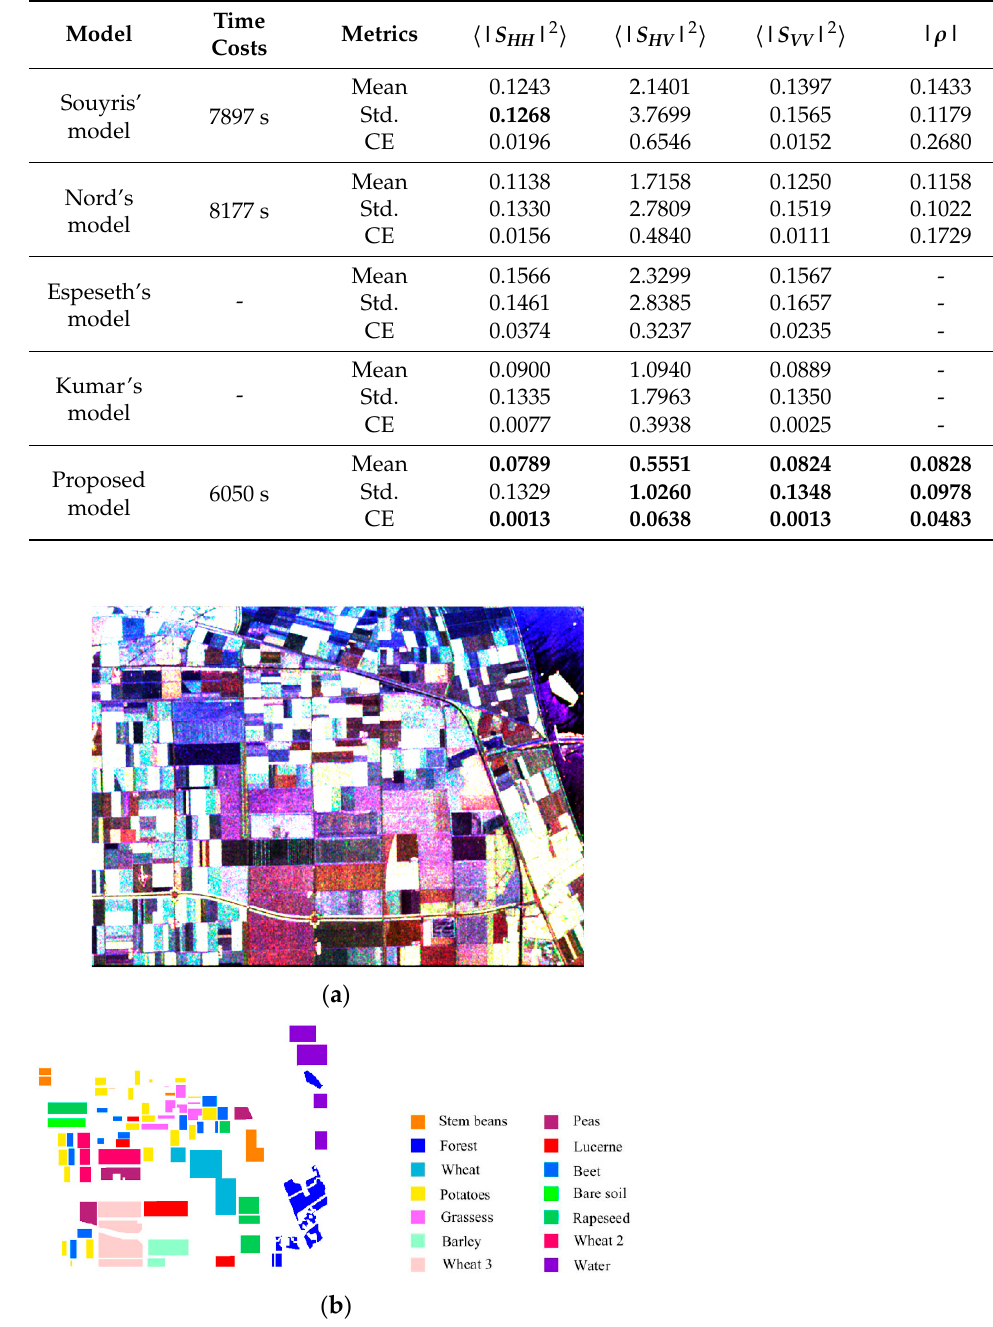
Table 3. Quantitative analysis of the parameters reconstructed using different models on ALOS-2 data.